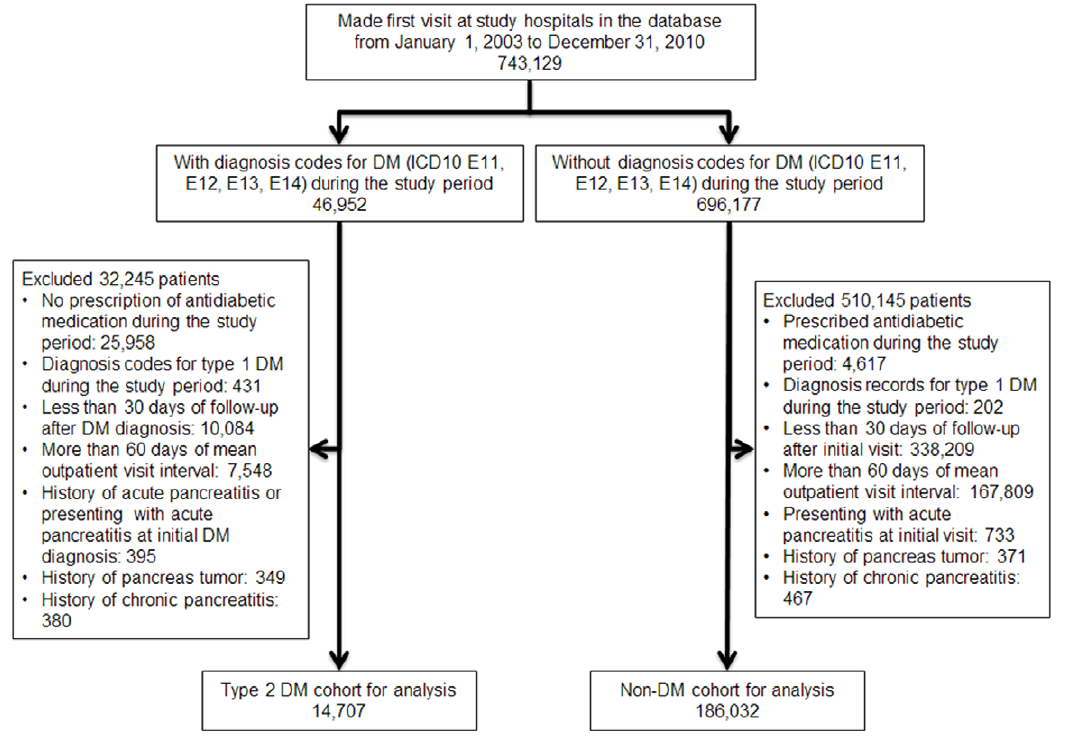
Figure 1. Patient selection criteria for cohort substudy of the risk of acute pancreatitis associated with type 2 diabetes mellitus. DM, diabetes mellitus; ICD10, International Statistical Classification of Diseases and Related Health Problems 10th Revision Version for 2003.